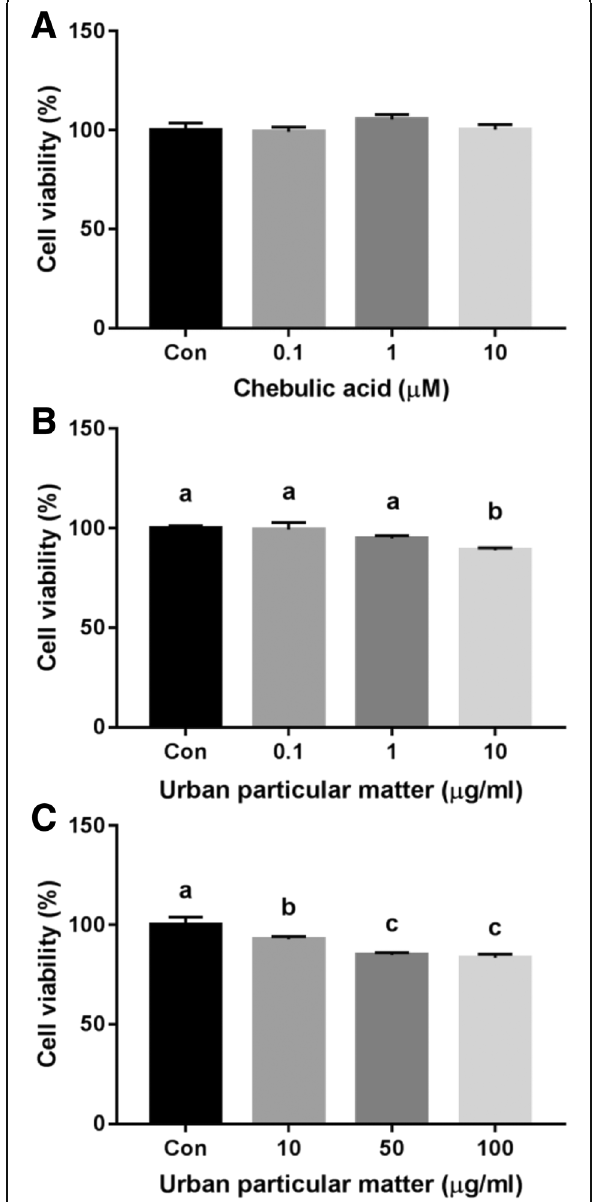
Fig. 1 Effect of chebulic acid (CA) and urban particulate matter (UPM; NIST 1648a) on cell viability. Effect of CA on the human pulmonary alveolar epithelial cell (NCI-H441) viability after 24 h ( a ). Cytotoxicity of UPM (0.1, 1, and 10 μ g/mL) on NCI-H441 after 24 h ( b ). Effect of exposure to UPM (10, 50, and 100 μ g/mL) on NCI-H441 for 6 h ( c ). Data are means ± SD of three experiments with triplicate samples and different letters indicate significant differences at p < 0.05 by Tukey ’ s multiple comparisons test